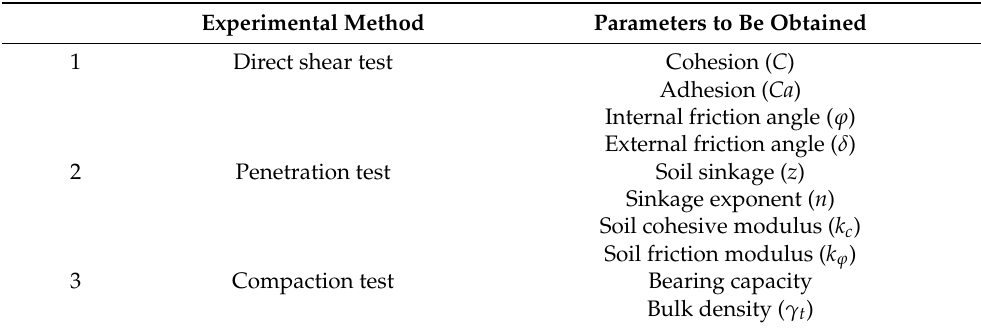
Table 1. Experiment arrangement of soil properties for tractive performance analysis.